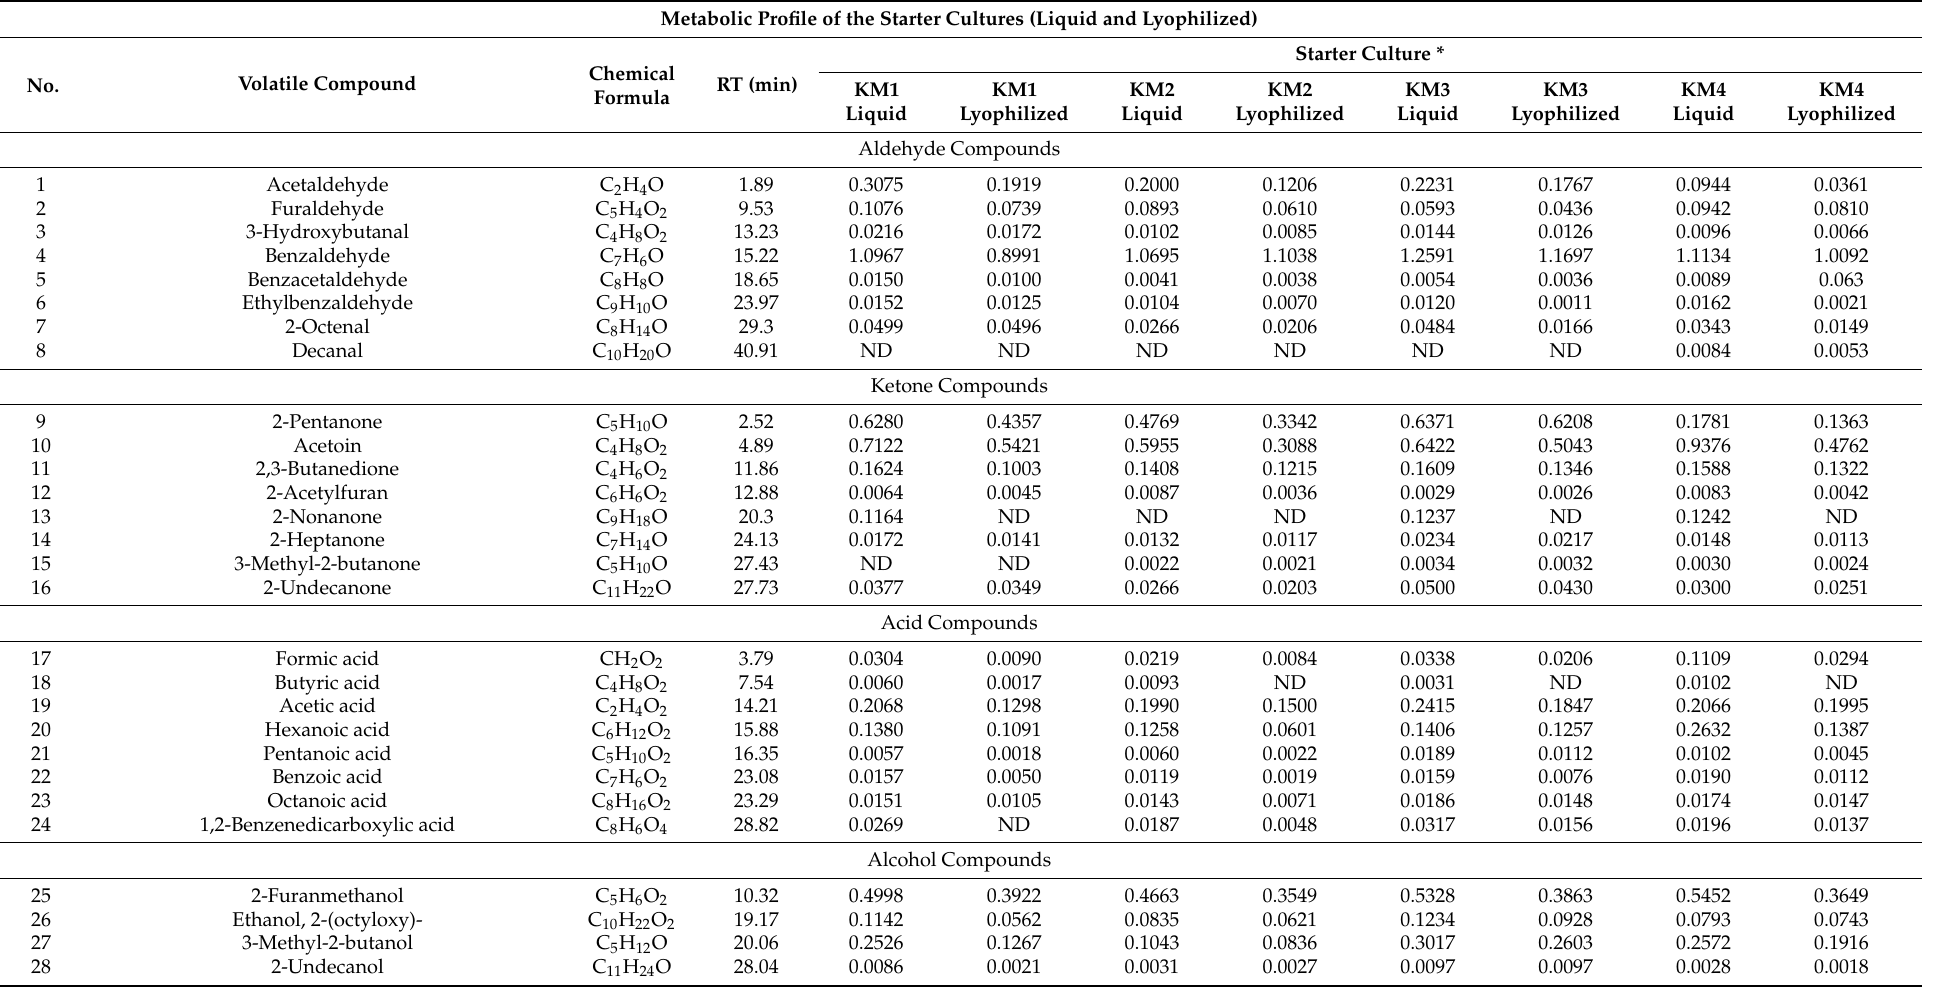
Table 3. Aromatic components produced from liquid and lyophilized symbiotic starter cultures KM1, KM2, KM3, and KM4. Metabolic Profile of the Starter Cultures (Liquid and